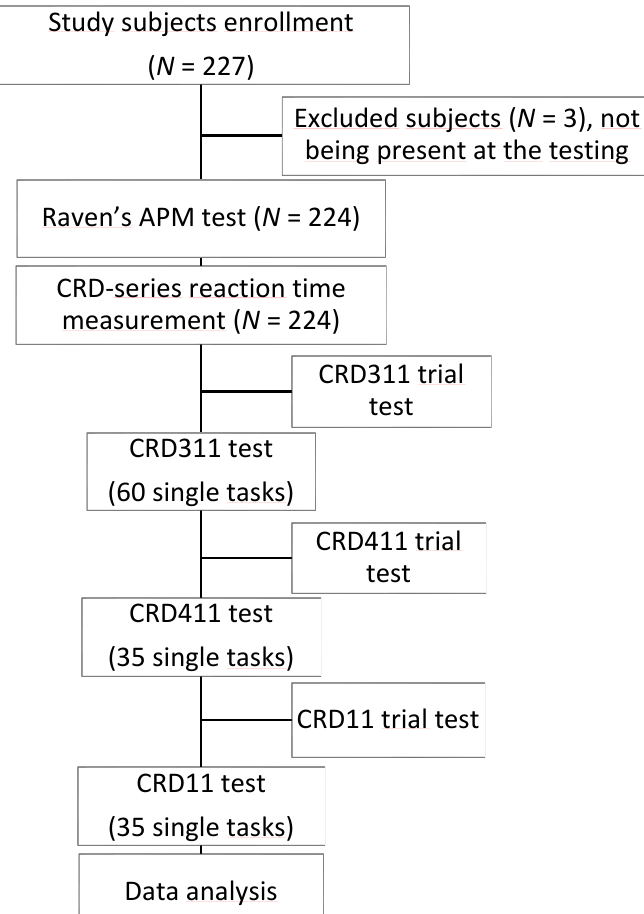
Figure 2. Study flow chart. A total of 224 medical students were tested with Raven’s APM and three tests (CRD311, CRD411, and CRD11) of the CRD-series test battery. APM = Advanced Progressive Matrices, CRD = Complex Reactionmeter Drenovac.